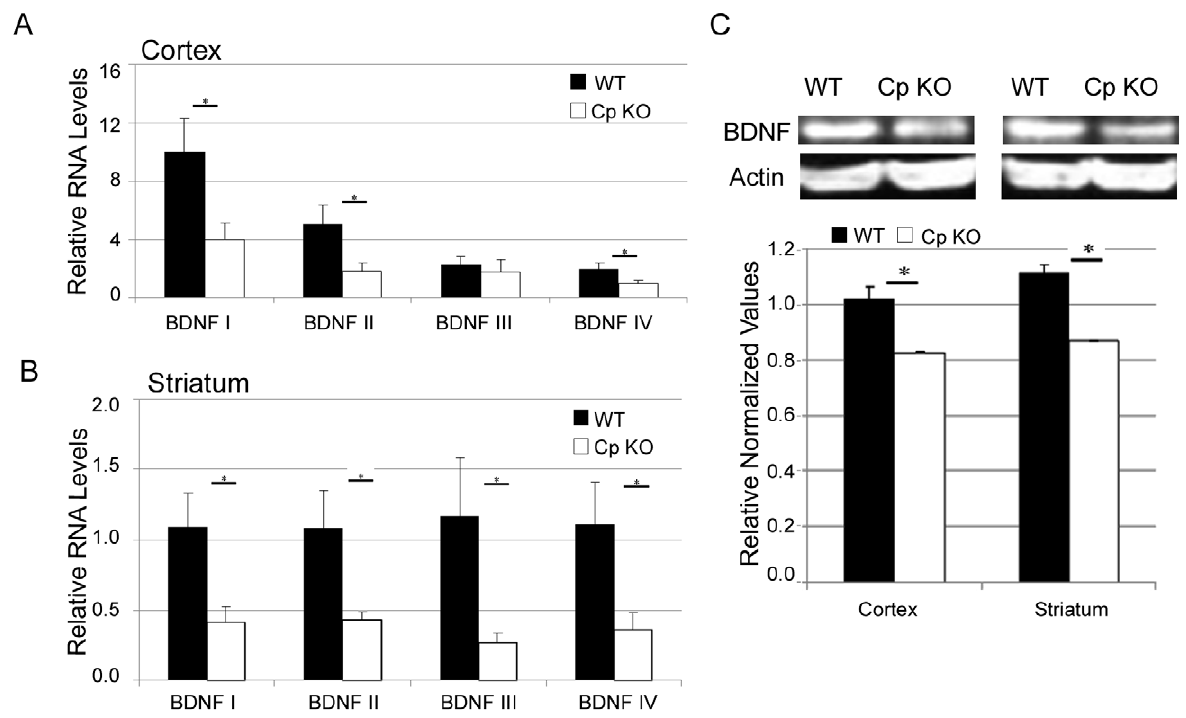
Figure 2. The expression of BDNF is reduced in the cerebral cortex and striatum of ceruloplasmin-deficient mice. A. RT-PCR measures of the 4 BDNF transcripts show a decrease in BDNF transcripts 1, 2 and 4 in the cortex of the CpKO mouse (*p , 0.04, n=5). B. RT-PCR measures of the 4 BDNF transcripts show a decrease in BDNF transcripts 1, 2, 3 and 4 in the striatum of the CpKO mouse (*p , 0.05, n=5). C. Examples of immunoblots of BDNF protein levels in the cortex and striatum (top panel) and densitometry results showing significant decreases BDNF protein levels (normalized to actin level) using Image J software. (*p , 0.03; n=4 WT and 3 CpKO mice).